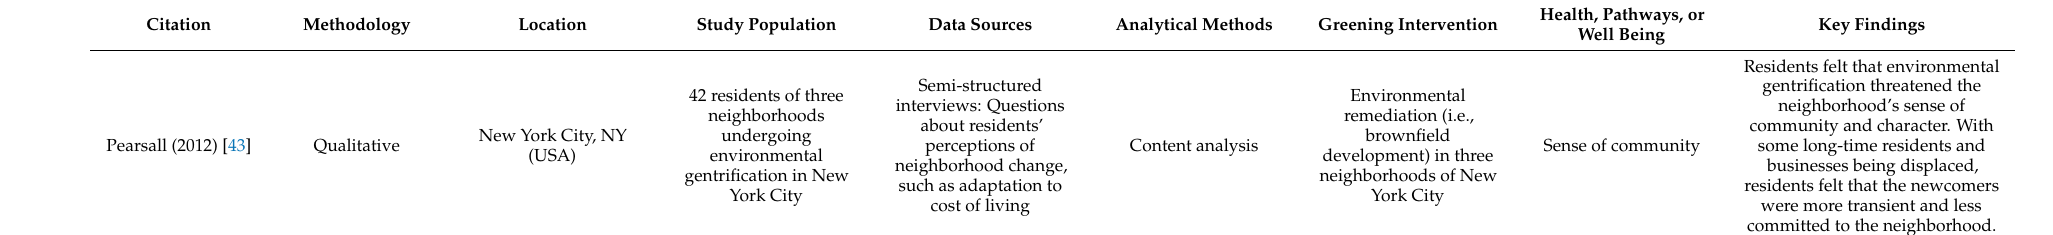
Table 1. Characteristics and key findings of the 15 included